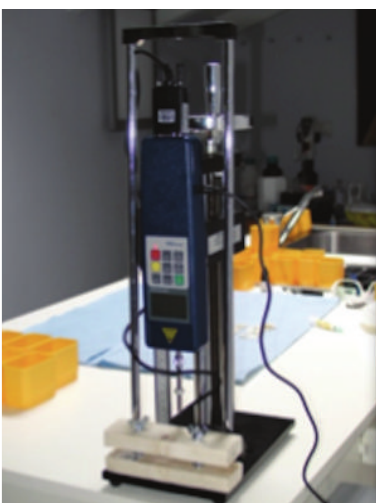
Figure 8: Digital dynamometer used for traction test.